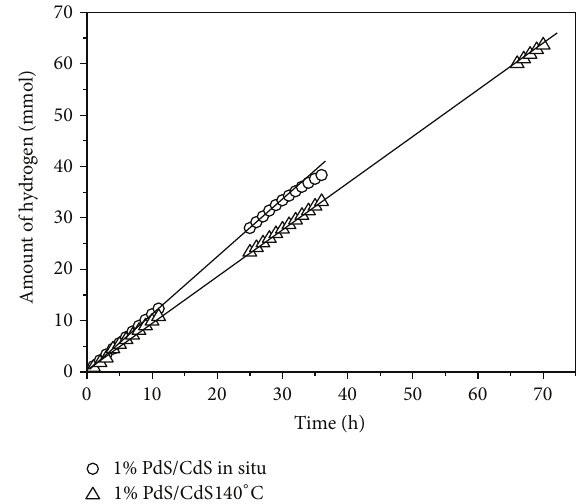
Figure 2: Time courses of hydrogen evolution on PdS/CdS samples loaded with 1wt% PdS prepared by different